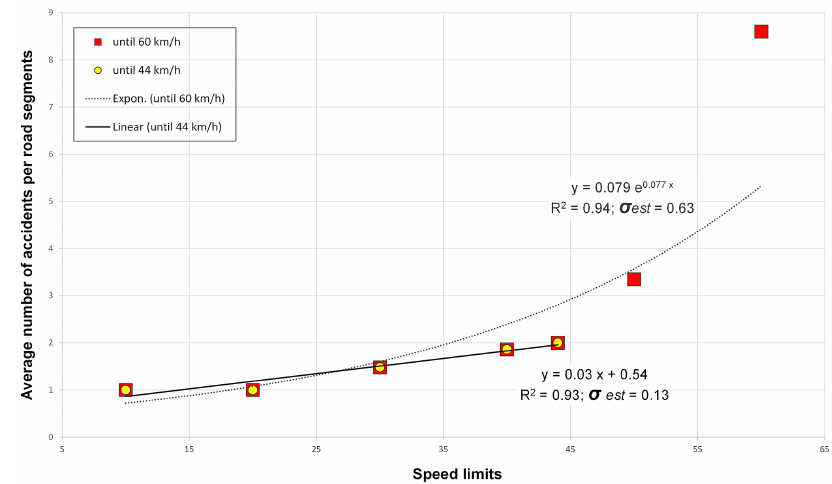
Figure 5. Graph correlating speed and traffic accidents